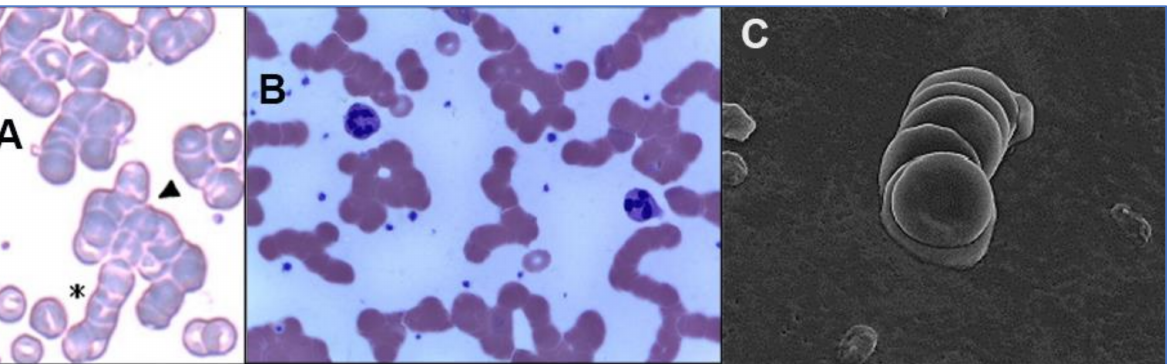
Figure 2. Images of RBC rouleaux (clumps) from the blood of COVID-19 patients, obtained using light (( A ) [112], ( B ) [113]) and electron microscopy (( C ) [114]). The first study ( A ) found huge rouleaux formation by RBCs in 85% of COVID-19 patients studied [112]; the second ( B ) found these in 33% of patients [113]; and the third ( C ) found these prevalent in its series of 31 patients, all with mild COVID-19 [114]. Reproduced with permission from ( A ) SIMTIPRO Srl; ( B ) CC-BY 4.0; ( C ) Georg Thieme Verlag